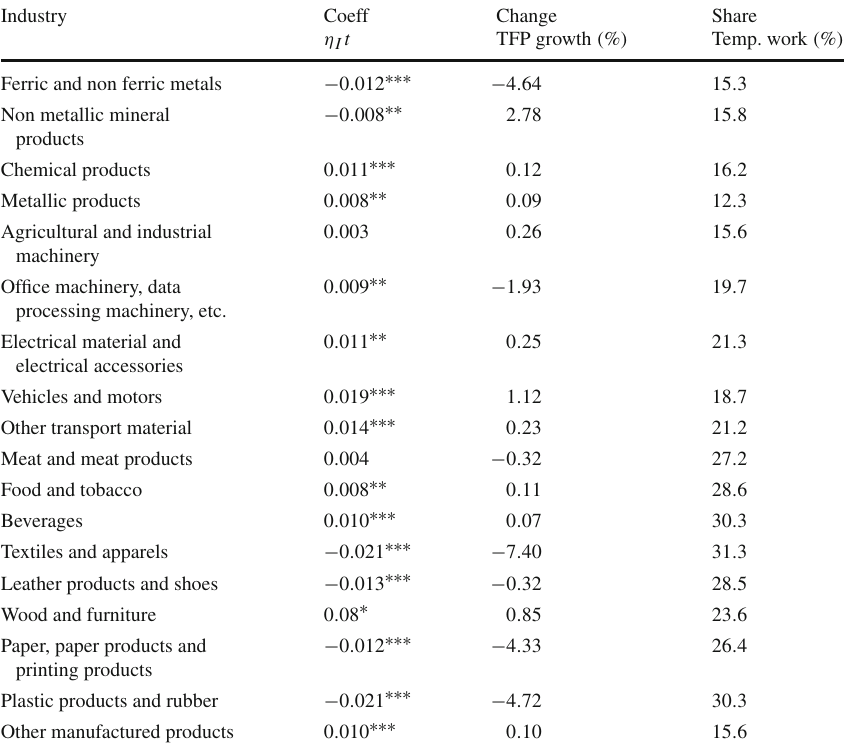
Table 9 Sys-GMM estimates of industry trend